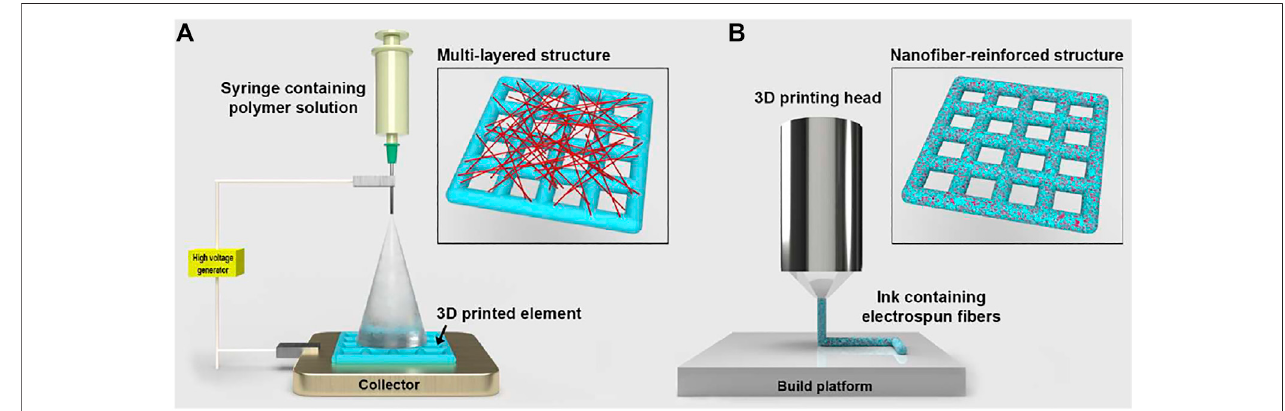
FIGURE 1 | Schematic representation of the two fabrication approaches that combine electrospinning and 3D printing (elements not in scale). (A) Deposition of electrospun nano fi bers onto one side ofa 3D printed element that is placed in contact with the metallic collector of the electrospinning apparatus. Inset: 3D printed layer covered with a low-density layer of electrospun fi bers. (B) 3D printing head depositing a polymeric ink reinforced with electrospun fi bers. Inset: composite 3D printed structure where nano fi bers are encapsulated within the